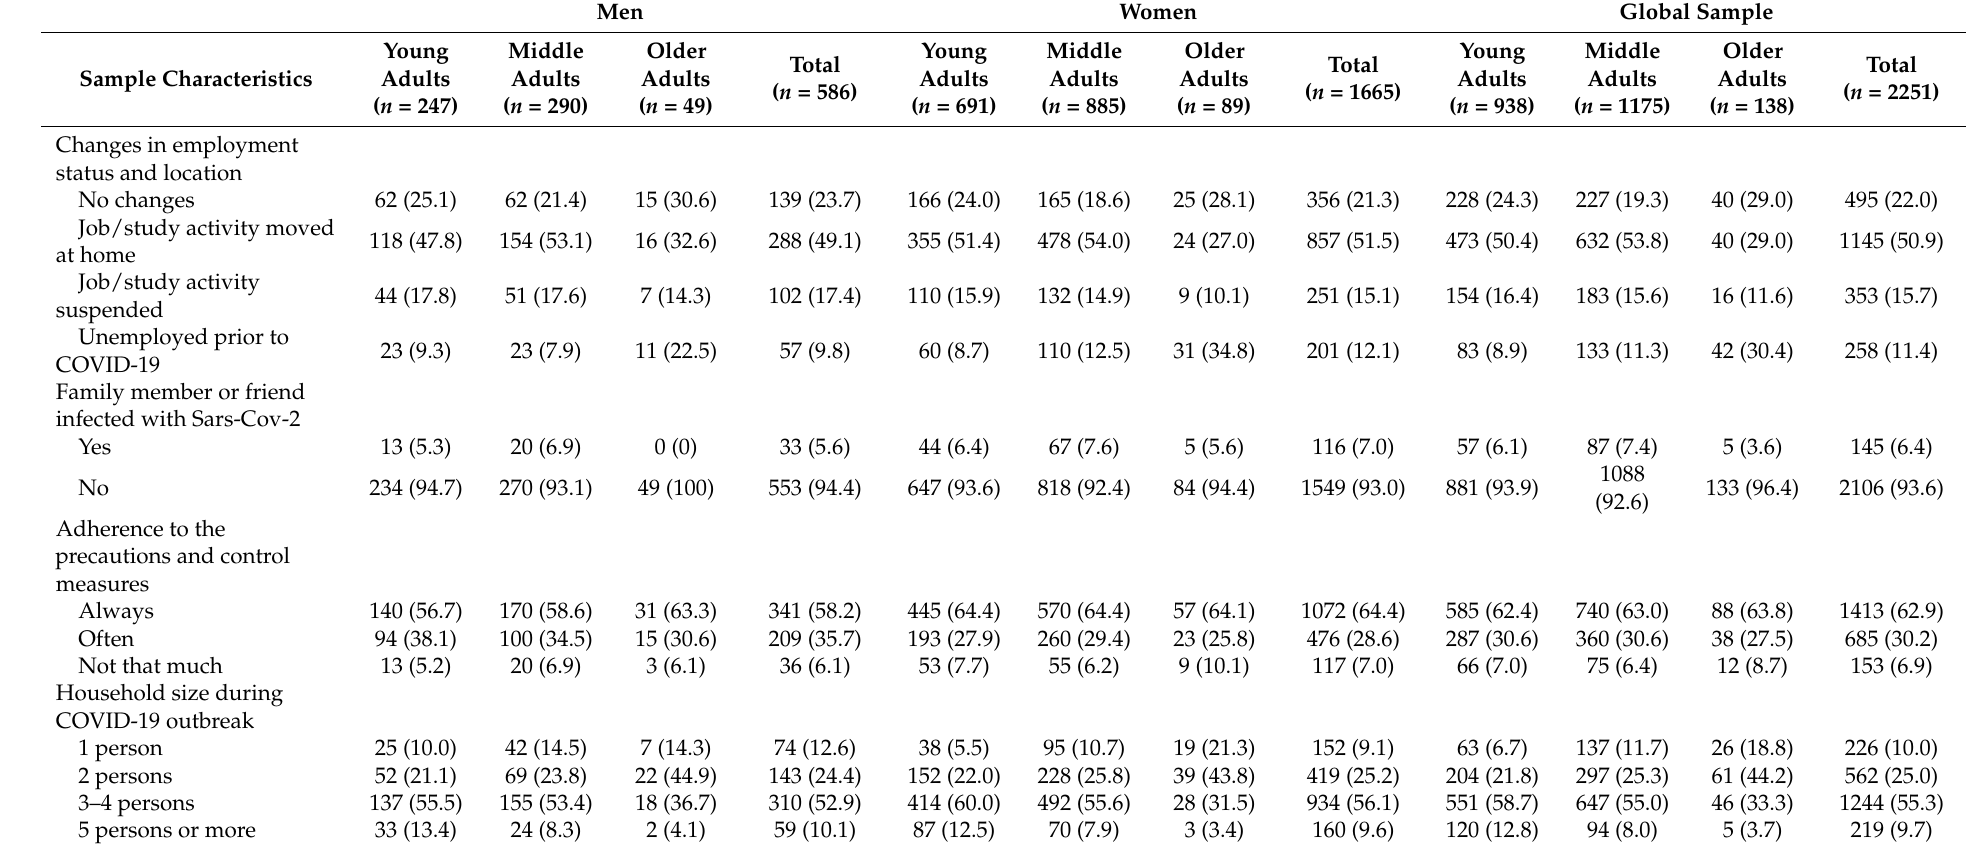
Table 2. Frequencies (%) of COVID-related information for men, women, and global sample by age range.